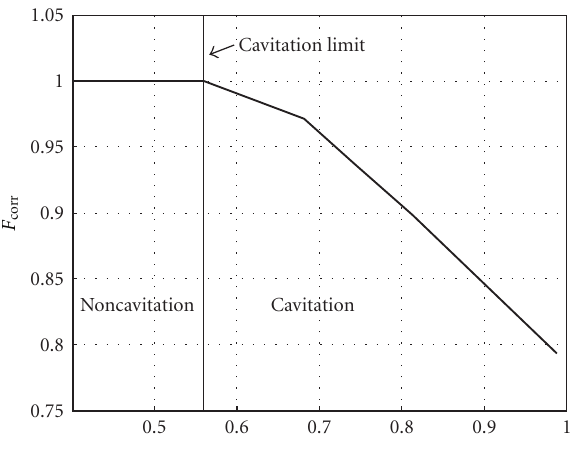
Figure 8: Correction function for pump cavitation.